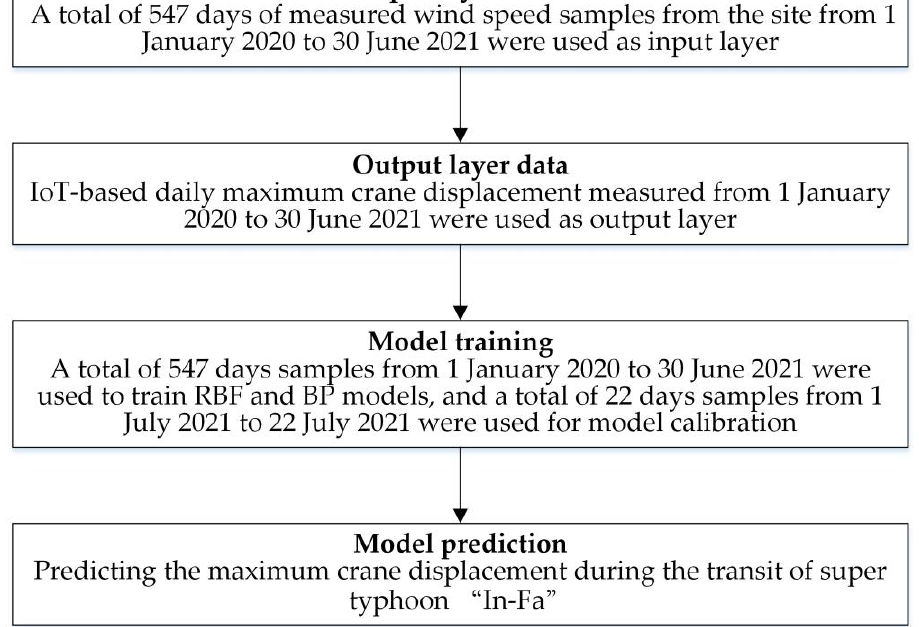
Figure 9. Construction of tower displacement response prediction model.